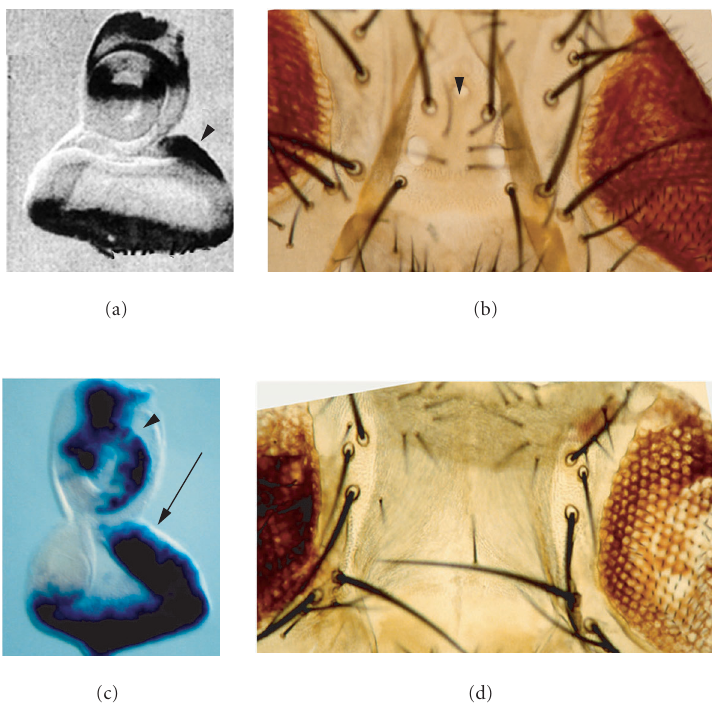
Figure 4. ptc and ci are crucial genes for ocellar development. (a) and (c) Eye-antennal discs stained with X-gal. (b) and (d) Dorsal views of the head capsules of flies of the indicated genotypes. (a) ptc-lacZ is expressed in the vertex primordium in the ptc-lacZ/+ eye discs (arrowhead). (b) Overexpression of ptc in the ocellar primordium in Gal4 C 591 /UAS-ptc flies results in smaller ocelli (arrowhead). (c) The Gal4 C 591 driver induces lacZ expression across the entire dorsal head primordium (arrow) as well as in the anlagen of the antenna (arrowhead) and in the compound eye. (d) In Gal4 C 591 /+ and UAS-ci76/+ flies, the three ocelli and associated bristles are eliminated. The entire ocellar region is